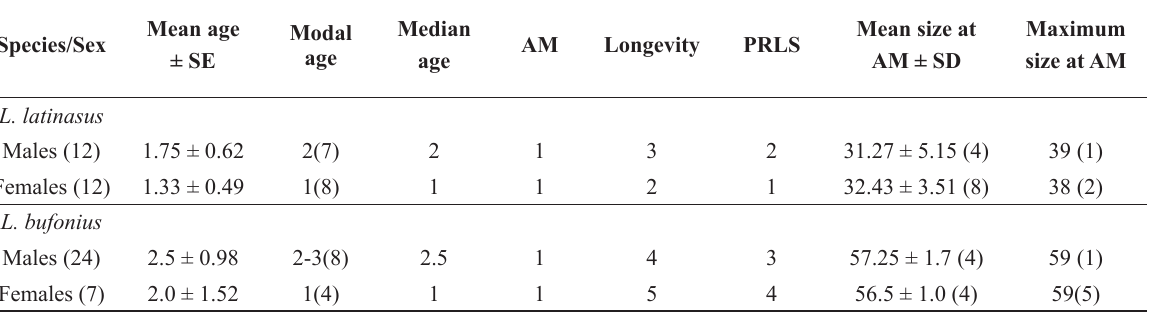
Age-related traits of Leptodactylus latinasus and L. bufonius . AM = age at maturity (i.e. the minimum age in the sample, in LAGs); Longevity = maximum age in the sample (LAGs); PRLS = potential reproductive lifespan (years); Mean and